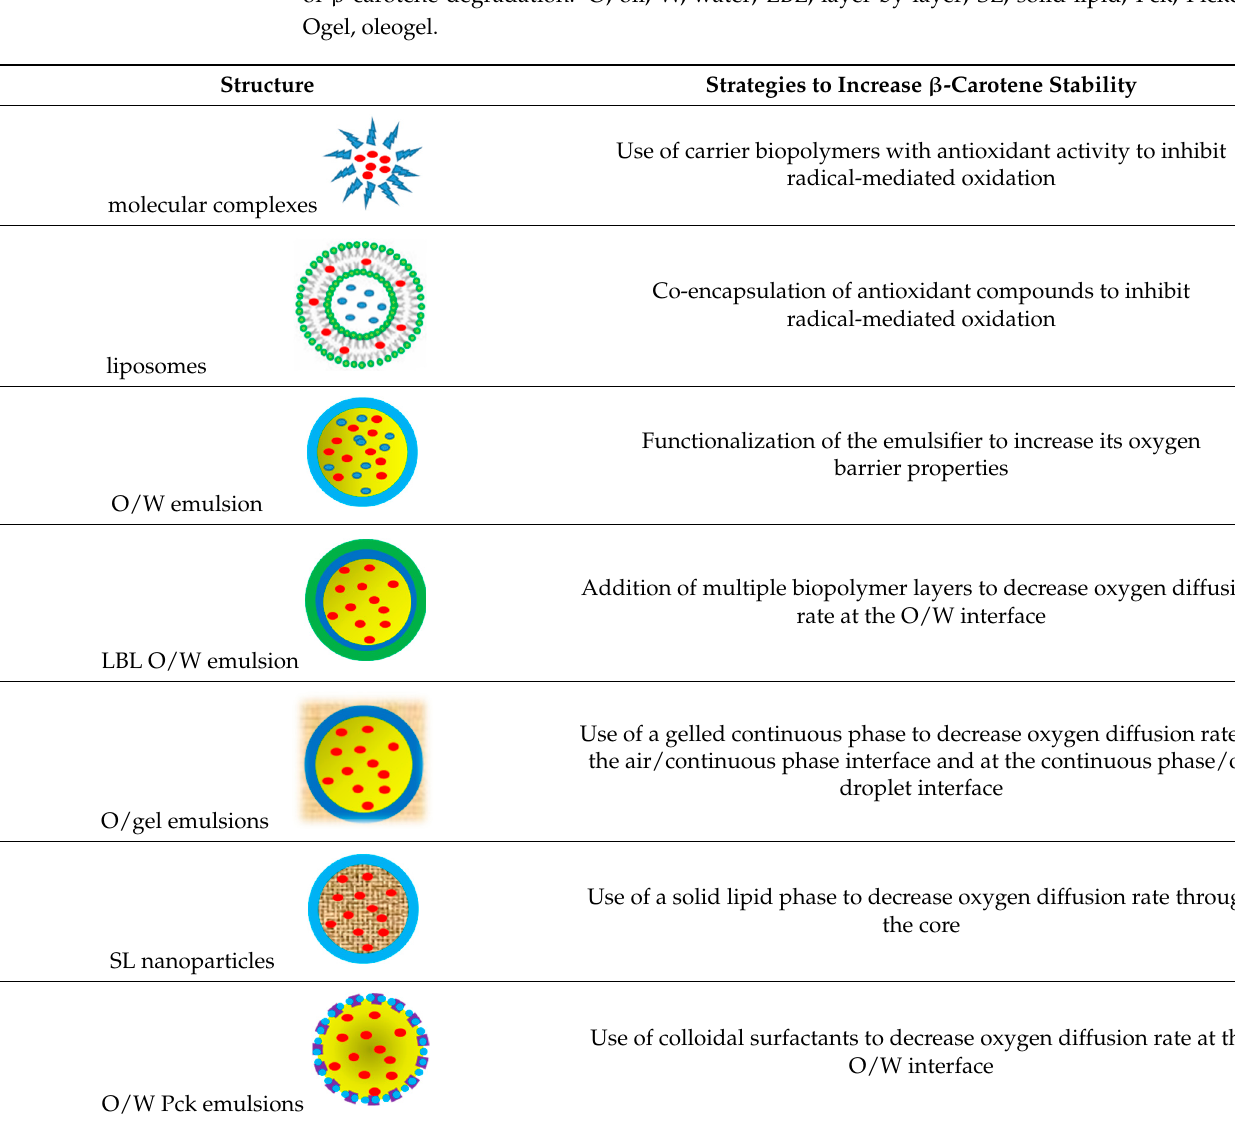
Table 3. Activation energy (Eatt, kJ/mol) in a given temperature range (T range, °C) for the degra- dation of β -carotene encapsulated in nano-and micro-structures in aqueous environments. Matrix